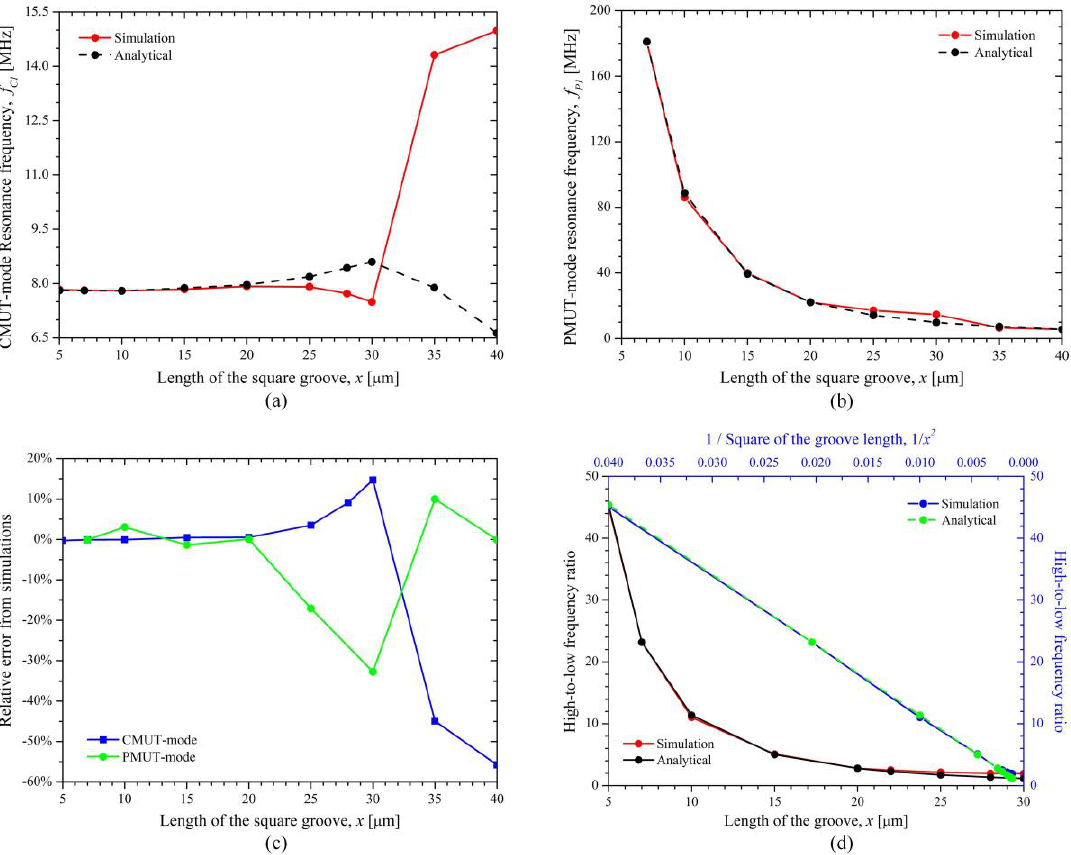
Figure 7. Fundamental resonance frequencies, ( a ) at CMUT operation; ( b ) at PMUT operation; ( c ) relative errors form simulations; ( d ) high-to-low frequency ratio of the DFUT when the length of the groove changes from 5 to 30 μm.